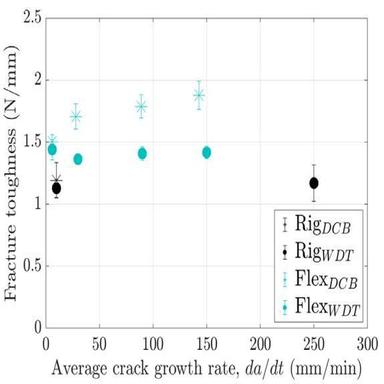
Fracture toughness vs. the average crack growth rate for rigid and flexible bonded joints tested with the DCB and the WDT+.